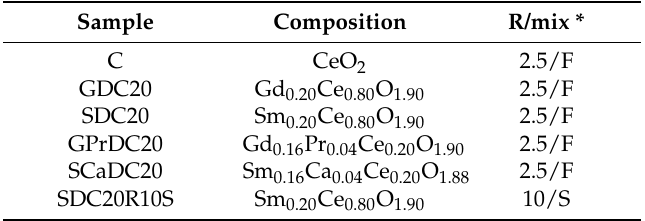
Table 1. Synthesized samples, composition, and coprecipitation